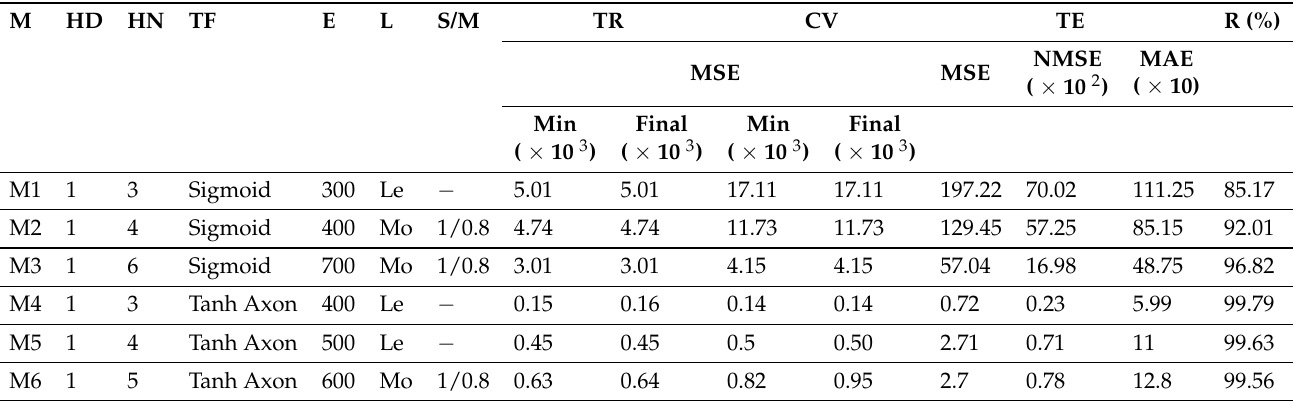
Table 7. Different developed ANN models.